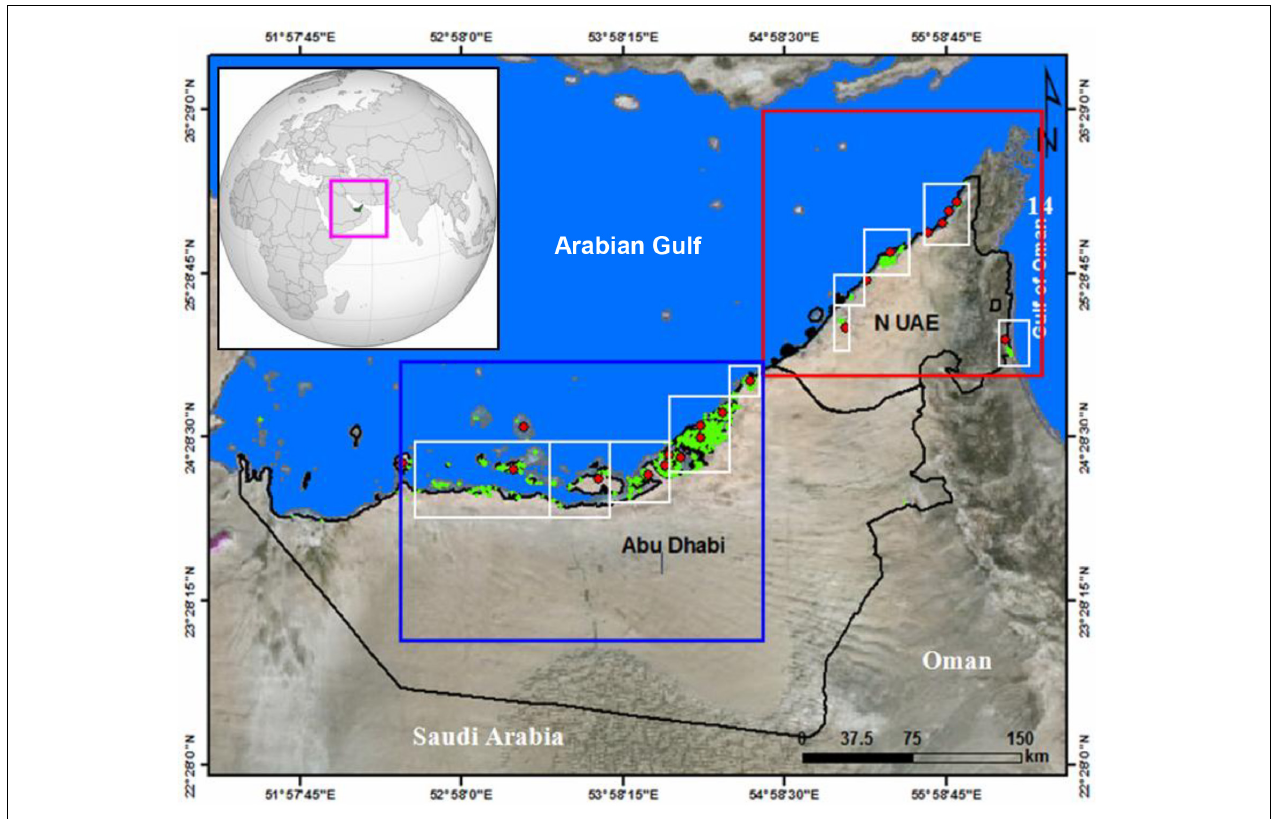
FIGURE 2 | RGB 541 band combination of Landsat image of the UAE showing the spatial distribution of the UAE mangroves and in the study area (red